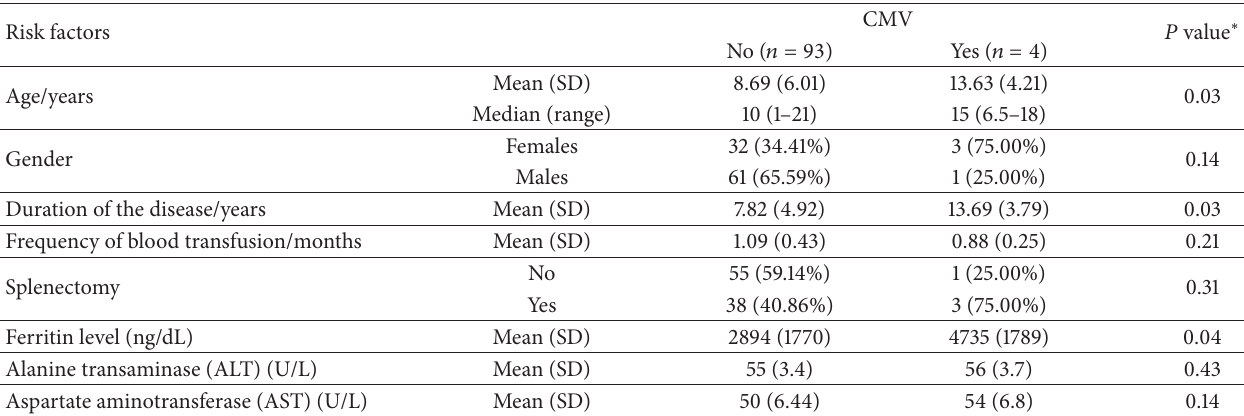
Table 5: Risk factors for